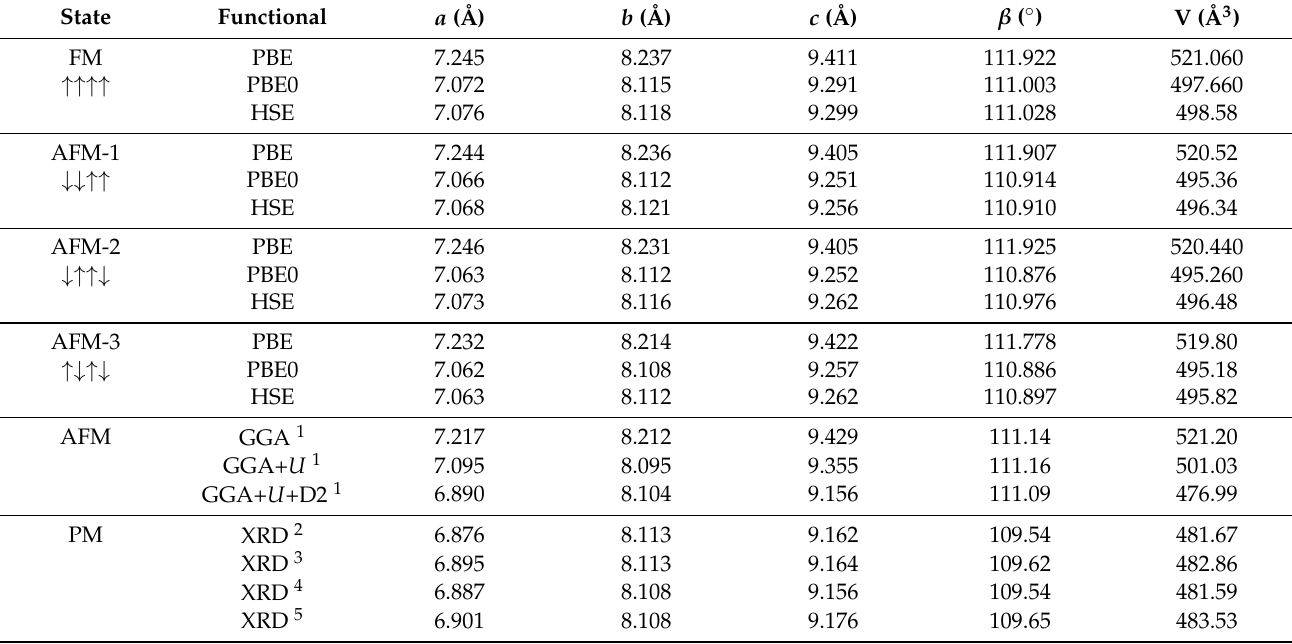
Table 1. Unit cell parameters of α -Cu 2 P 2 O 7 in comparison with previous theoretical [23] and room- temperature experimental [14,15,22,23] results. Up and down arrows denote a possible order of magnetic moments on sites Cu1–Cu4, see Figure